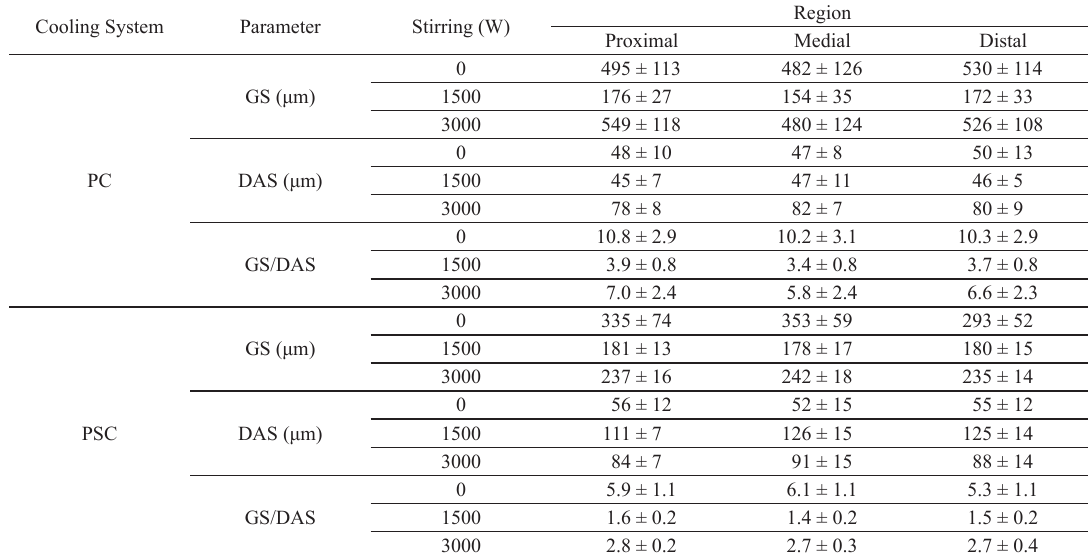
Table 2. Values of microstructural parameters (average ± standard deviation) for the distal, medial and proximal regions of an ingot cast by route 4 with PC and PSC and without EMS (0 W) and with EMS (1500 and 3000 W). All values in µm. Cooling